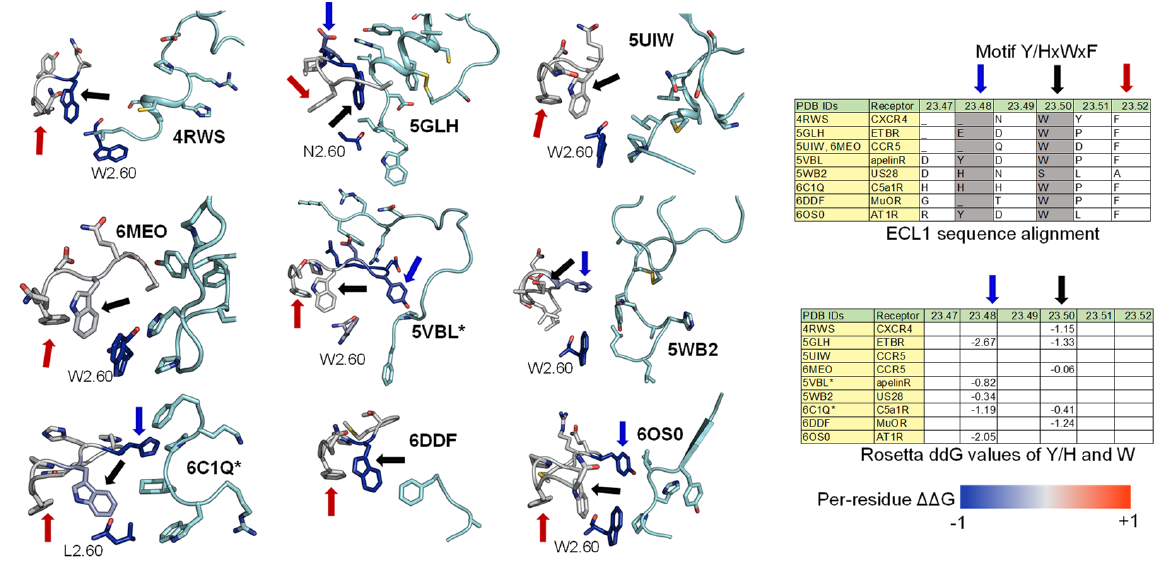
Figure 5. ECL1 and the role of motif Y/HxWxF in peptide binding among class A GPCRs with peptide ligands. ( Left ) Interactions among ECL1, residue 2.60, and the peptide. The interacting peptide residues are colored in cyan. Residues on ECL1 and 2.60 are colored based on their computed per-residue ∆∆ G values (blue: Negative ∆∆ G, darkest blue: − 1 or below; grey: ∆∆ G value of 0 or no interactions; red: Positive ∆∆ G, darkest red: 1 and above). ( Right ) The tables show the sequence alignment of ECL1 and the three key residues in ECL1 motif Y/HxWxF are Y/H, W23.50, and F23.52, which are marked with blue, black, and red arrows, respectively.